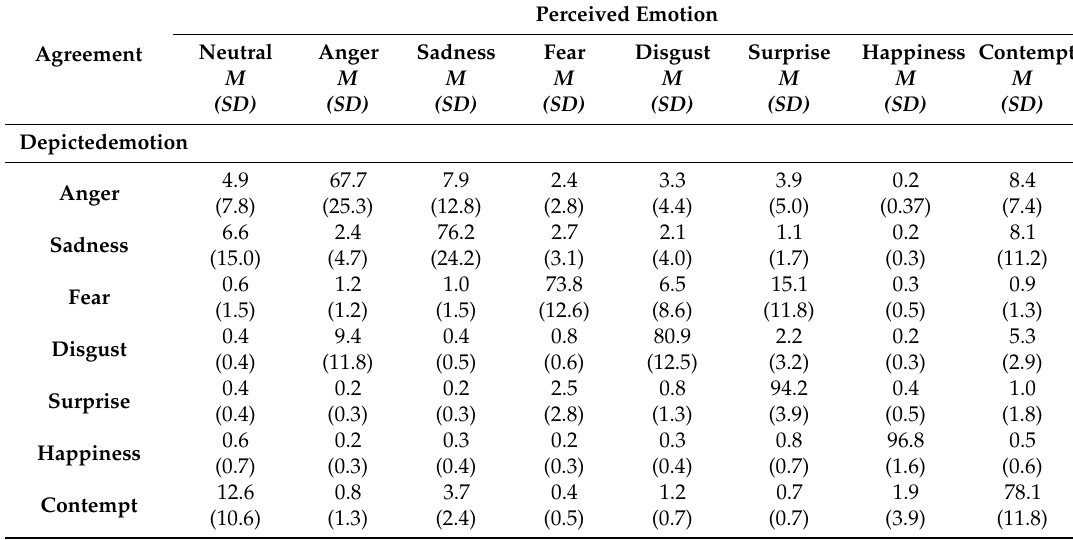
Table 1. Mean and standard deviation ( SD ) of agreement and mean unbiased “hit-rates” per expression